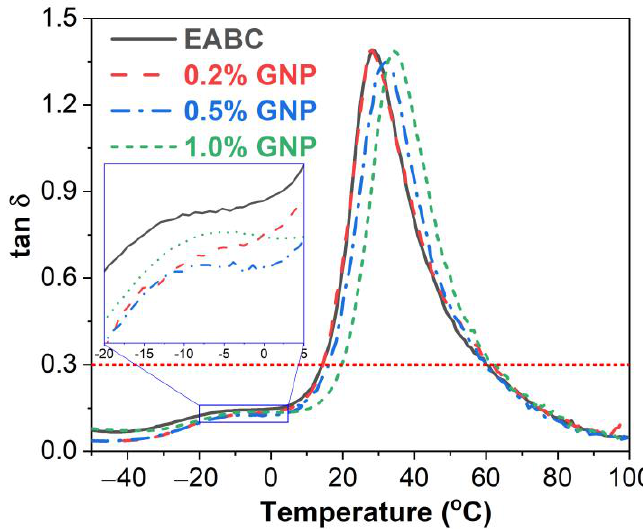
Figure 8. tan δ as a function of temperature of GNP-reinforced EABCs.